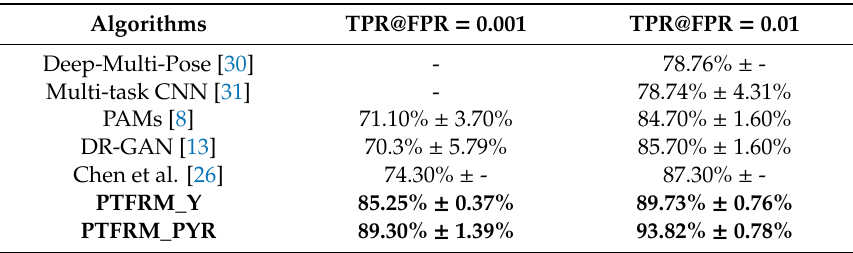
Table 4. TPR of different algorithms in IJB-A face verification (1:1). Algorithms